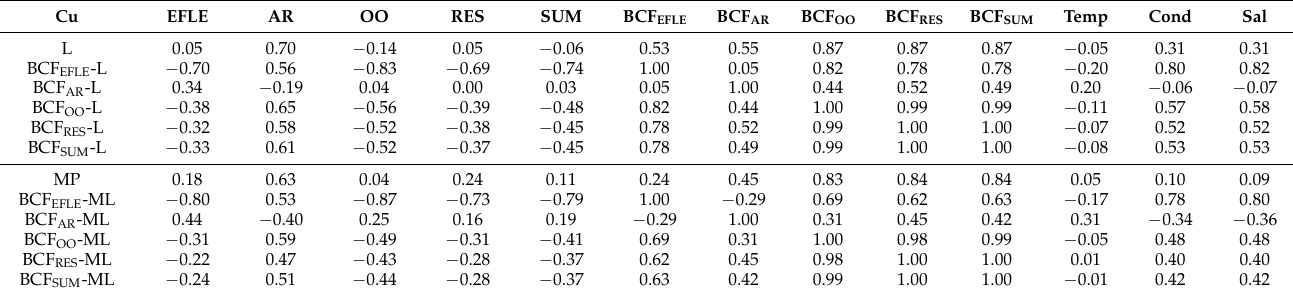
Table 8. Copper correlation coefficients between variable A (Cu levels in the lamina (L), midrib plus petiole (MP), and Cu bioconcentration factors (BCF)) and variable B (geochemical fractions in the sediments and surface water parameters). Values in red are significant at p < 0.05.